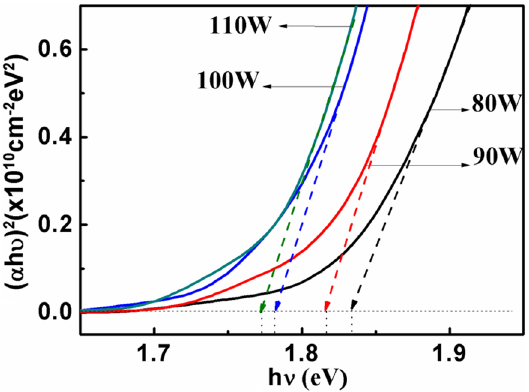
Figure 4. Optical absorption spectra of InN samples deposited on sapphire substrates at different sputtering power: 80 W, 90 W, 100 W and 100 W.